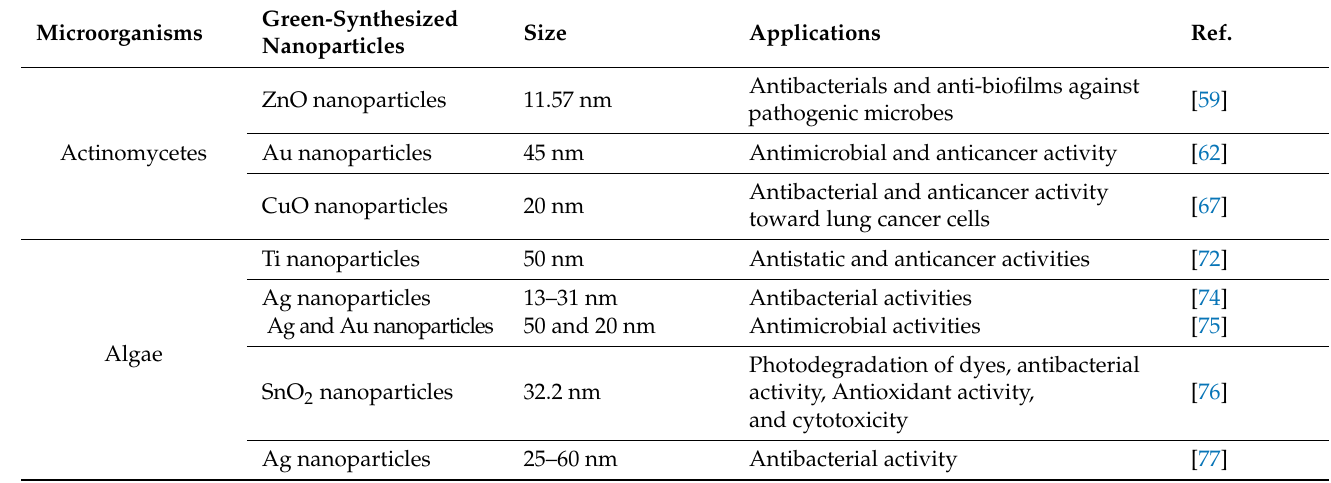
Table 3. Microbial synthesis of NMs using different types of